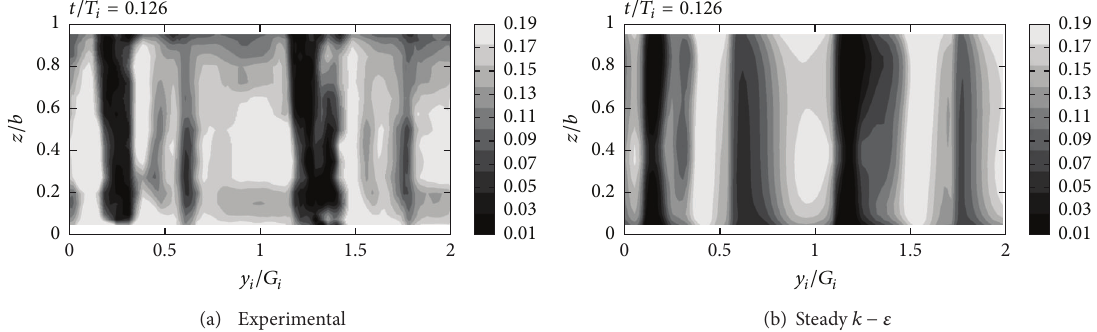
Figure 3: Experimental and calculated radial velocities in the radial gap for the steady-state simulation using the 𝑘 − 𝜀 turbulence model.